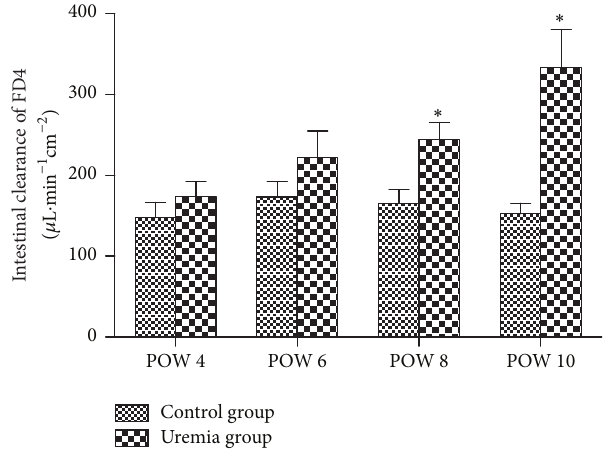
Figure 4: Intestinal clearance of FD4 in each group. POW: postop- erative week. Data are expressed as mean ± SD. ∗ 𝑃 < 0.05 , versus control group at the same time